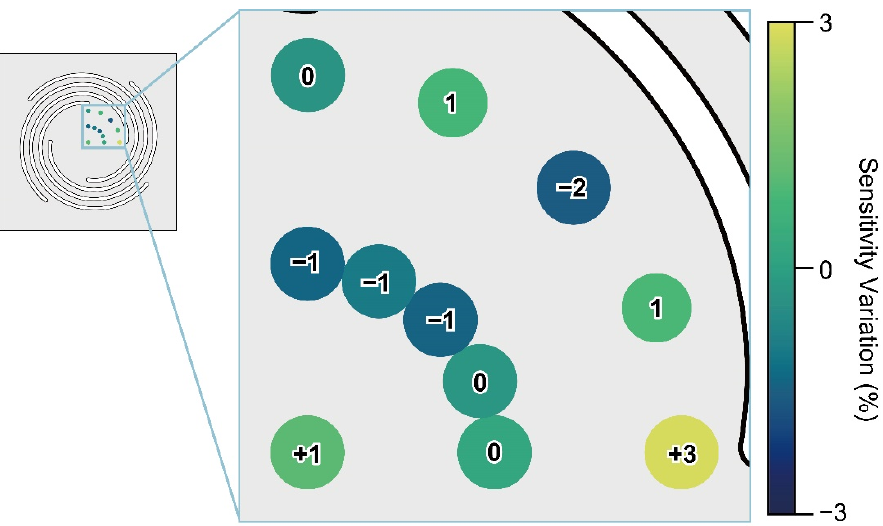
Figure 12. Sensitivity variation obtained by the experiments.